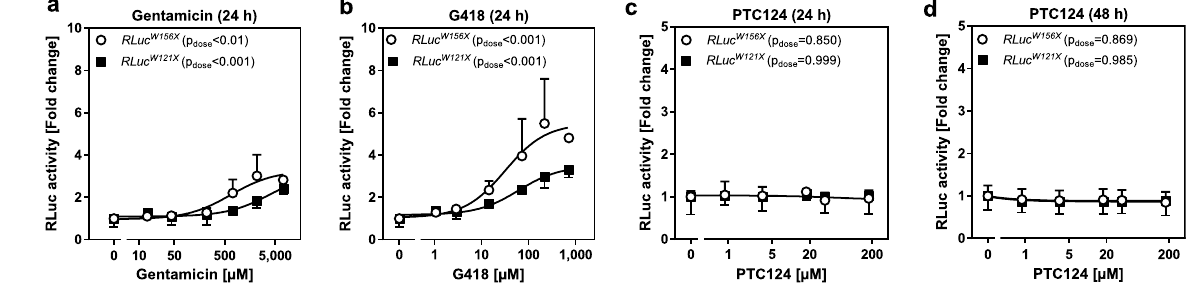
Figure 6. Aminoglycosides but not PTC124 suppress nonsense mutations in the Renilla luciferase. HEK293 cells were transfected with either the RLuc W121X or RLuc W156X overexpression construct. Two days after the transfection, cells were treated for 24 h with ( a ) G418, ( b ) gentamicin, ( c ) 24 h or ( d ) 48 h with PTC124 (n = 3–4, SD). Statistical significances were tested by one-way ANOVA with compound concentration as independent variable.